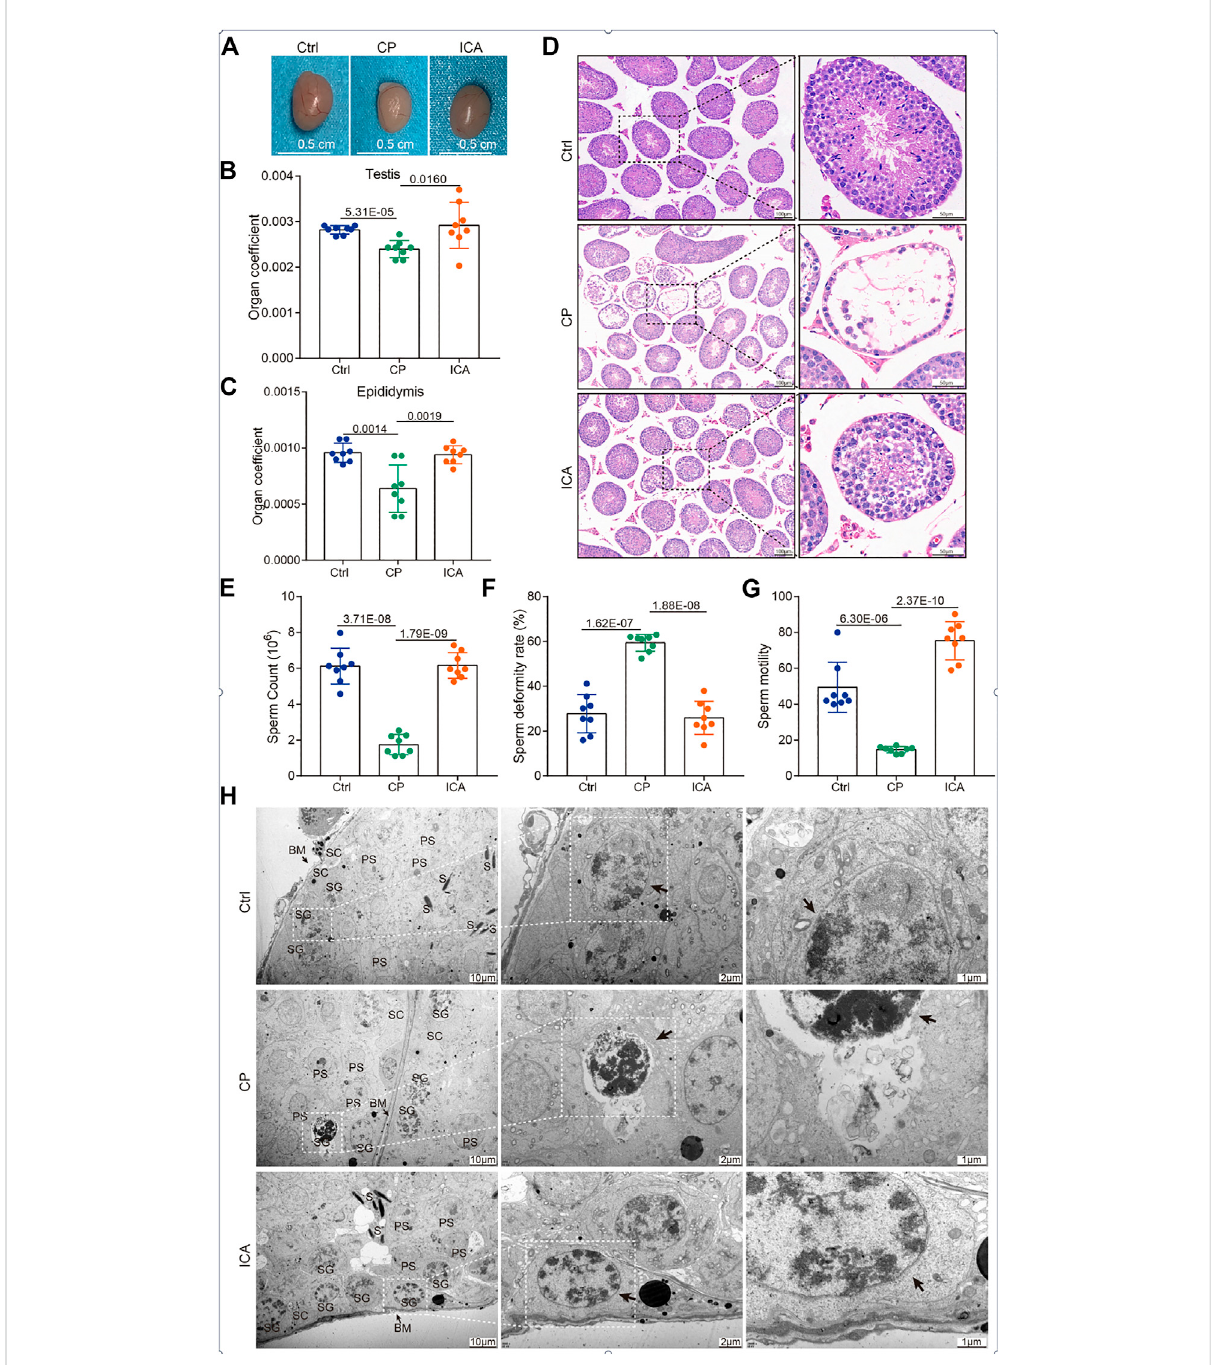
FIGURE 1 ProtectiveeffectsofICAontheCP-inducedtesticulardamagemicemodel. (A) Grossmorphologyofthetestis. (B) TheeffectofICAonthetestis coef fi cient. (C) The effect of ICA on the epididymis coef fi cient. (D) Representative images of H&E staining (100 × and 400 ×) of the testis from differentgroupsas indicated ( n = 8). (E) ICA increases sperm counts induced byCP inmice. (F) ICA attenuatessperm deformityinmale mice. (G) ICA improved sperm motility. p < 0.05 was considered statistical difference ( n = 8). (H) The ultrastructural changes of testis were observed under TEMfromdifferentgroups( n =3).BM,basementmembrane;SG,spermatogonia;S,spermatid;SC,Sertolicells;PS,primaryspermatocyte.Theblack arrow indicates